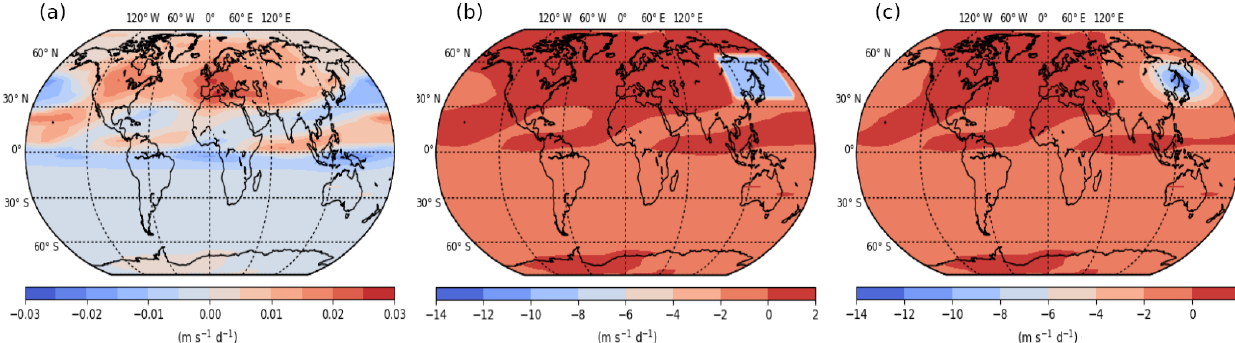
Figure 2. Zonal GW drag (ms − 1 d − 1 ) at 26.9km for the reference (a) and the H3 hotspot simulation as a box (b) and as a Gaussian distribution (c) for the last 30d of analysis. Note the different scale for panel (a)